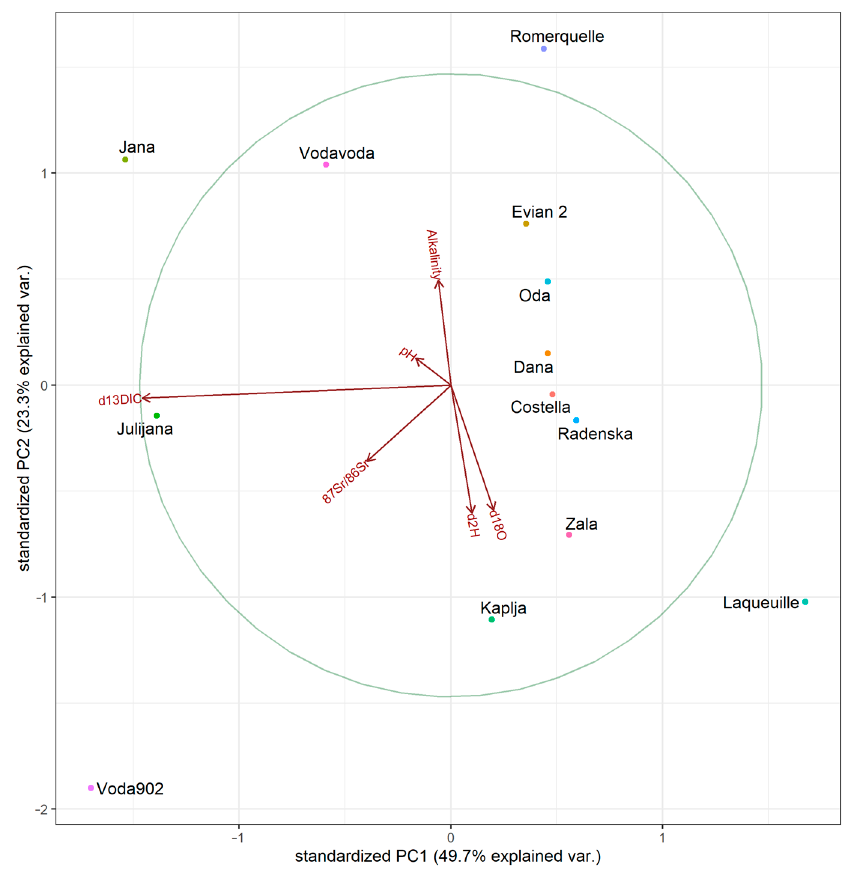
Figure 9. Biplot of the first two principal component axes of the PCA of stable isotopes, alkalinity, and pH in samples of bottled water.